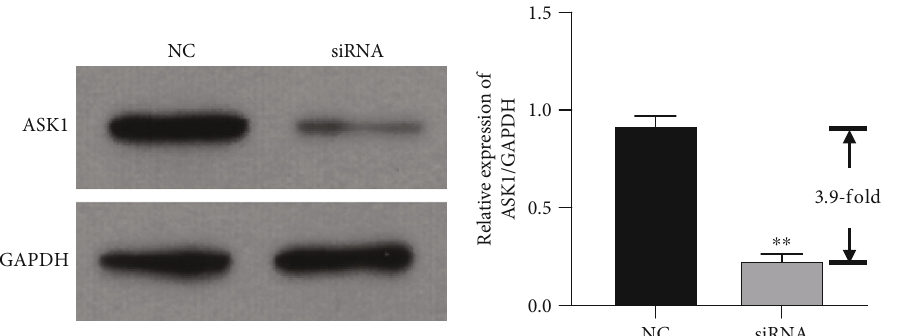
Figure 8: Expression of ASK1 was inhibited by siRNA. Expression of ASK1 was signi fi cantly suppressed by siRNA-targeting ASK1. ∗∗ p < 0 : 01 vs.